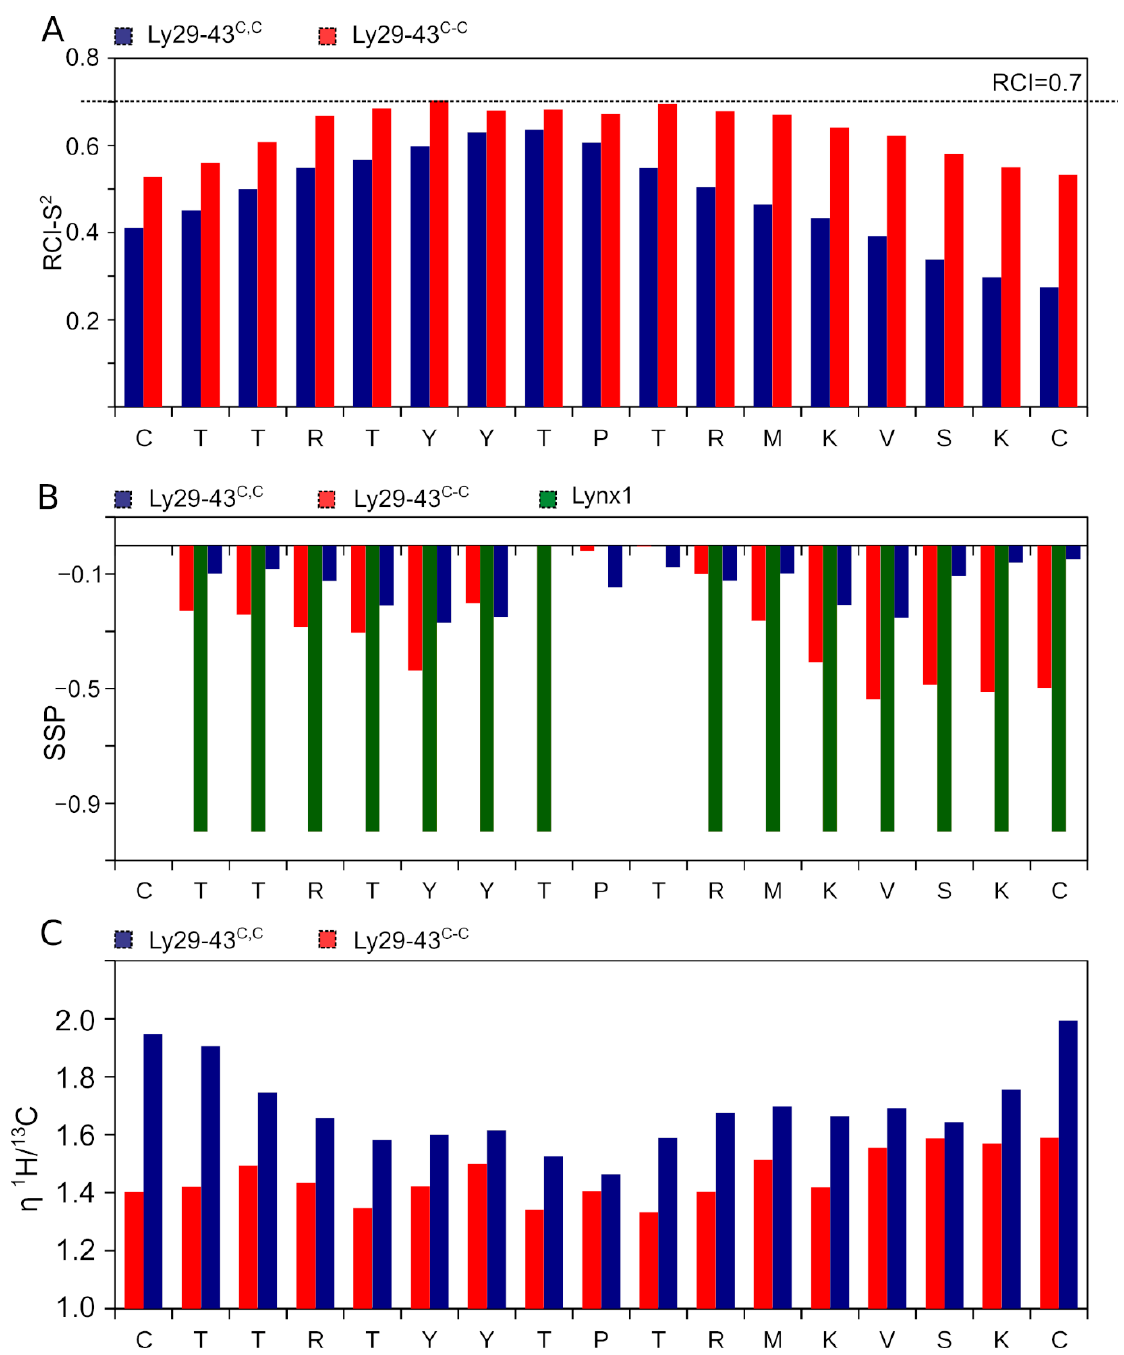
Figure 3. Distributions of RCI-S 2 ( A ), SSPs ( B ) and 1 H, 13 C steady-state NOEs ( C ) for Ly29–43 C,C (blue bars) and Ly29–43 C-C (red bars). Negative values of SSP correspond to the β -sheet or extended conformation. SSPs for the secondary structure of the homologous to Ly29–43 region of full-length human Lynx1 (PDB ID: 2L03) is shown by green bars on panel B for comparison. Heteronuclear NOE was measured at 30 °C and 700 MHz.